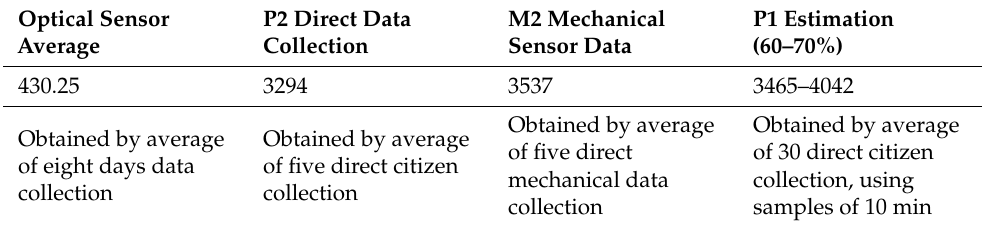
Table 13. P2, Segarra street data comparison. Vehicles by